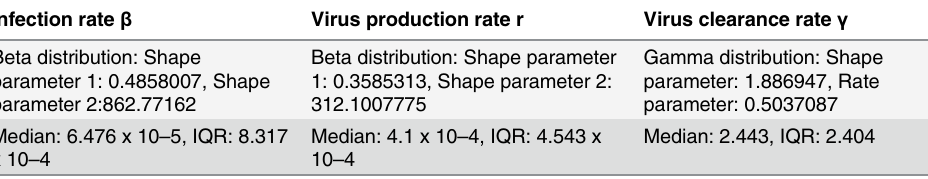
Table 2. Distribution of within-host model parameters in simulation studies based on estimated parameters from challenge studies. IQR: inter-quartile range. Infection rate